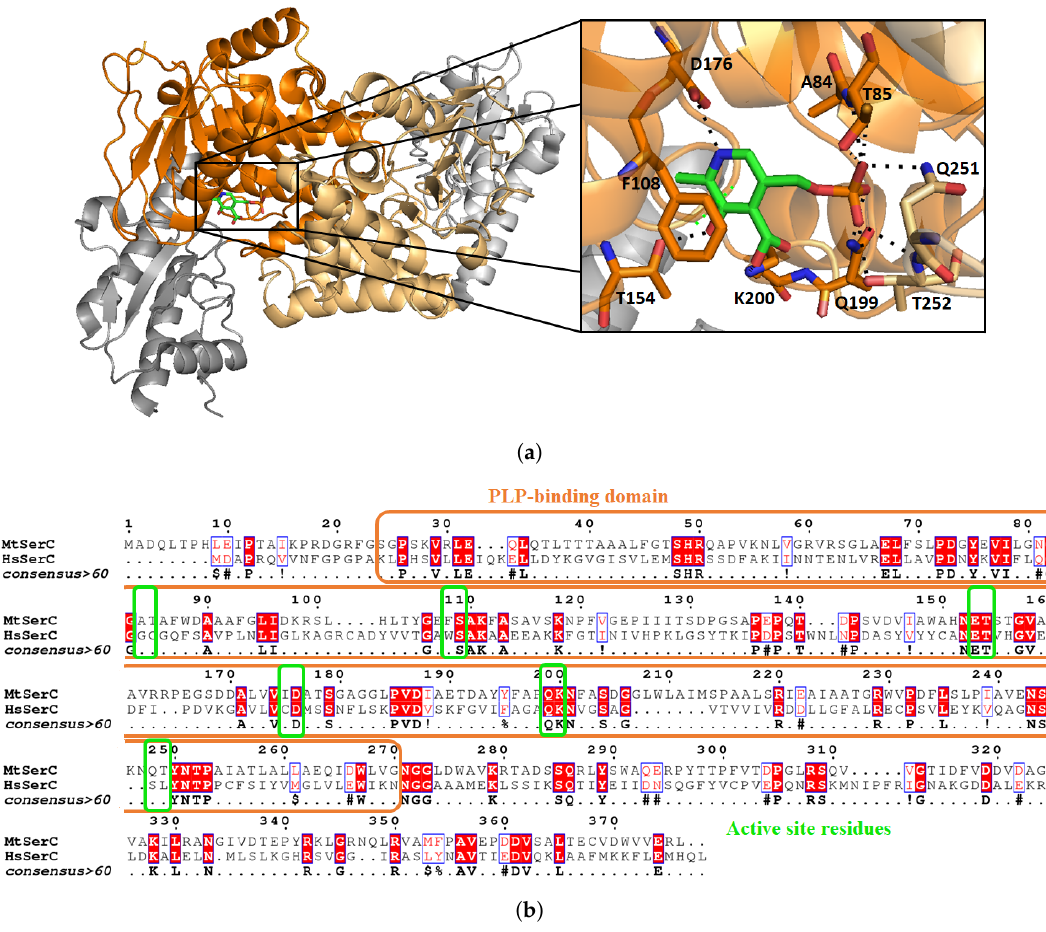
Figure 9. Structure of MtSerC homodimer (2FYF) with the substrate binding domains in orange. Zoom on the active site which contains SerC cofactor pyridoxal 5 (cid:48) -phosphate (PLP, ( a )). Sequence alignment of MtSerC and human PSAT with substrate binding domain in orange and active site residues in green. The percentage identity between both proteins is 23.6% and the similarity of 40.9% ( b